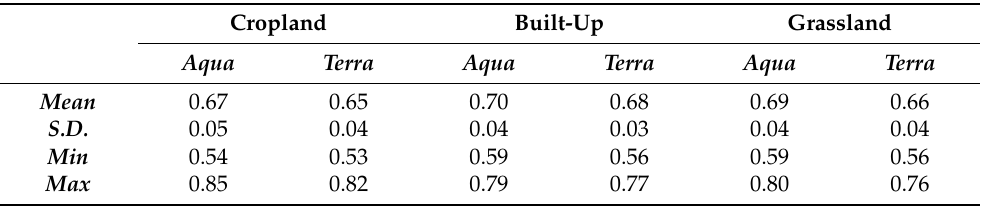
Table 4. Statistical analysis of Aqua and Terra AOD for LULC classes in the current region. Cropland Built-Up Grassland